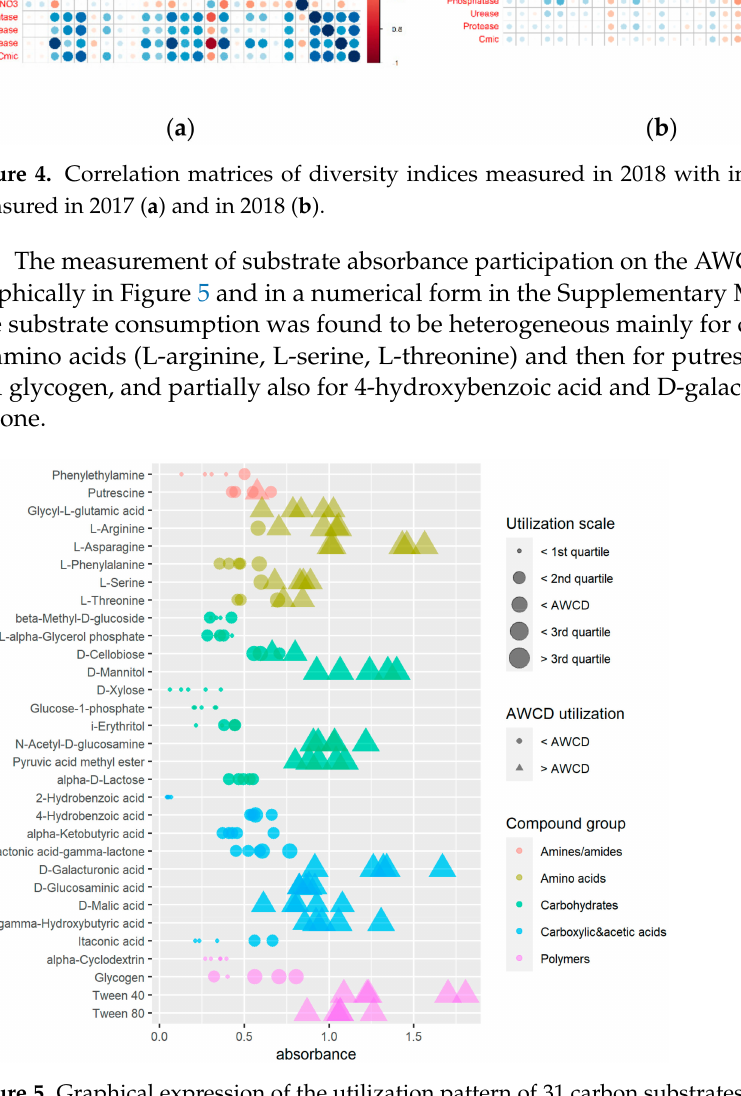
Figure 5. Graphical expression of the utilization pattern of 31 carbon substrates in the treatments in relation to the AWCD